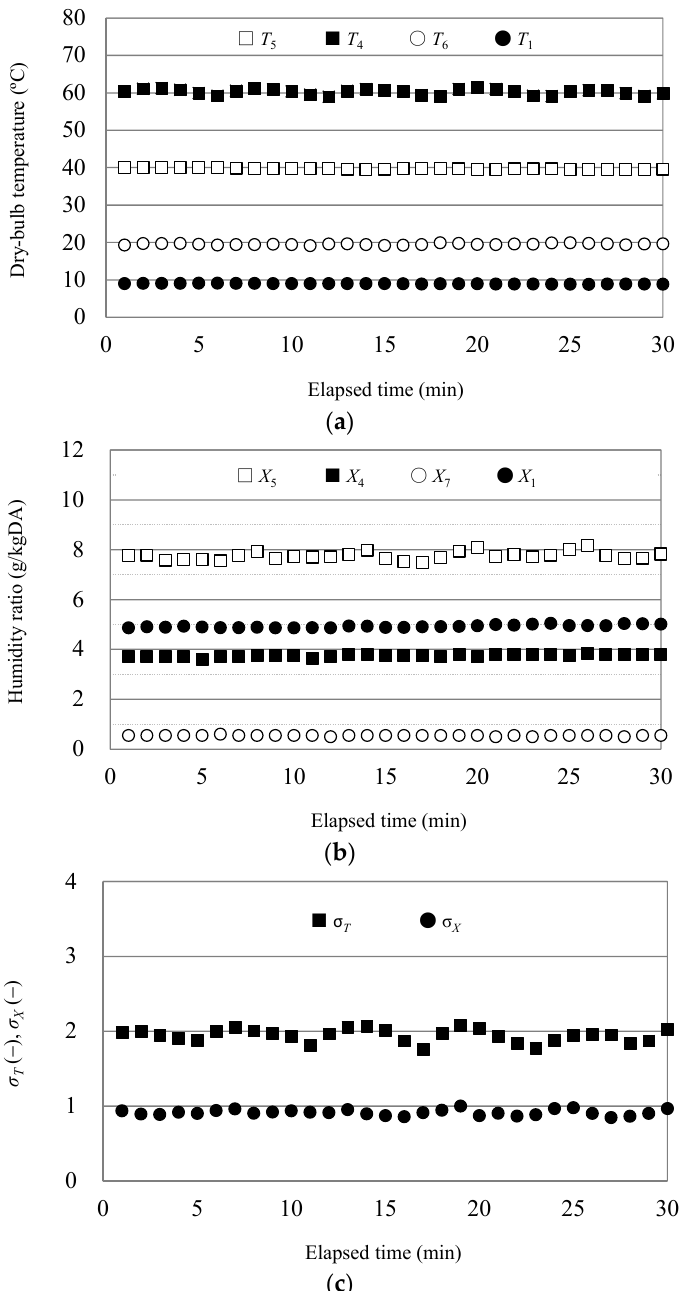
Figure 4. Experimental results of Case A1 at regeneration temperature of 60 °C on time charts for ( a ) inlet temperature and outlet temperature; ( b ) inlet humidity ratio and outlet humidity ratio; and ( c ) ratio of temperature differences and ratio of humidity ratio differences.